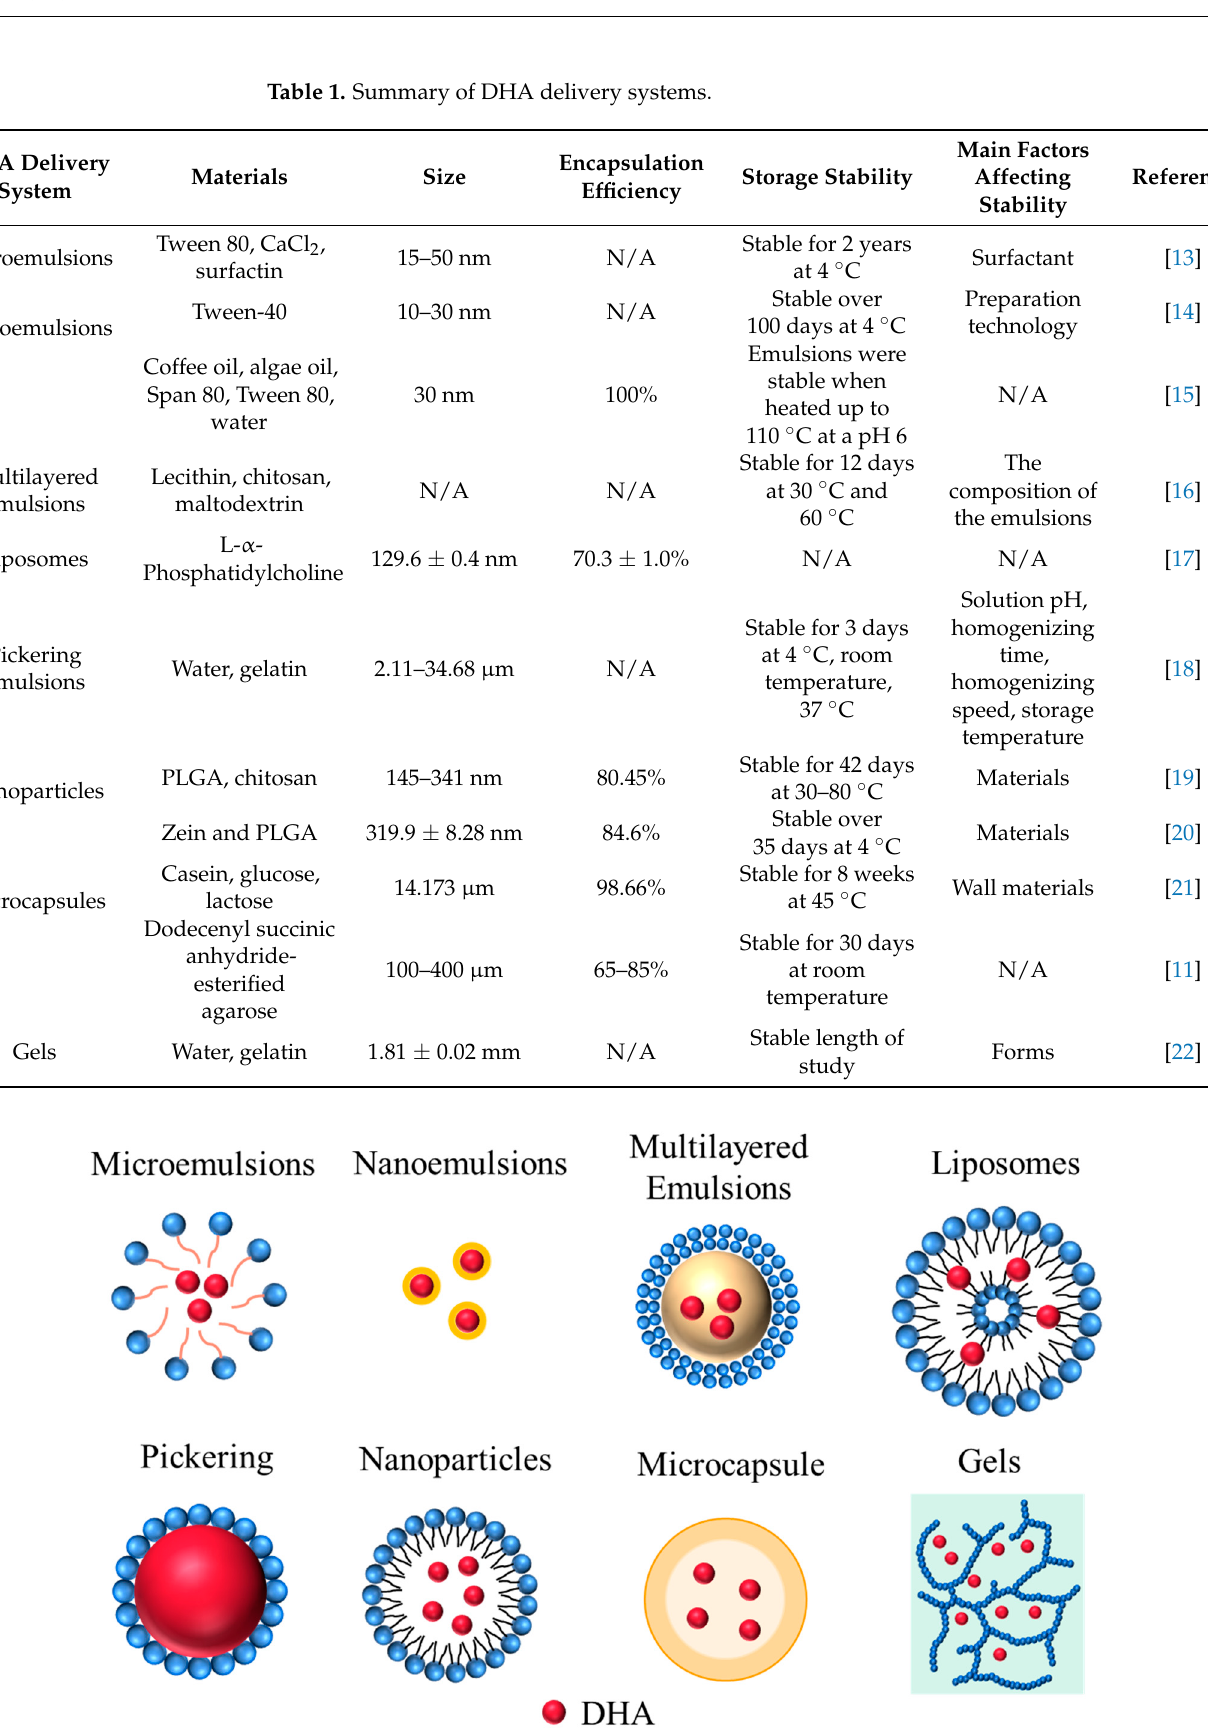
Figure 2. Depiction of different delivery systems indicating the possible location of DHA. Table 2. Functionality of DHA in delivery systems.